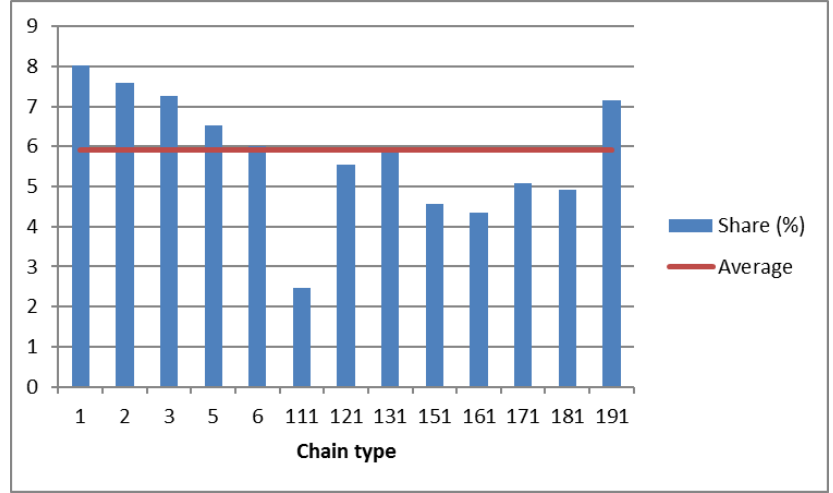
Figure 5. Corridor chains as percentage of international (> 1t) ones by chain